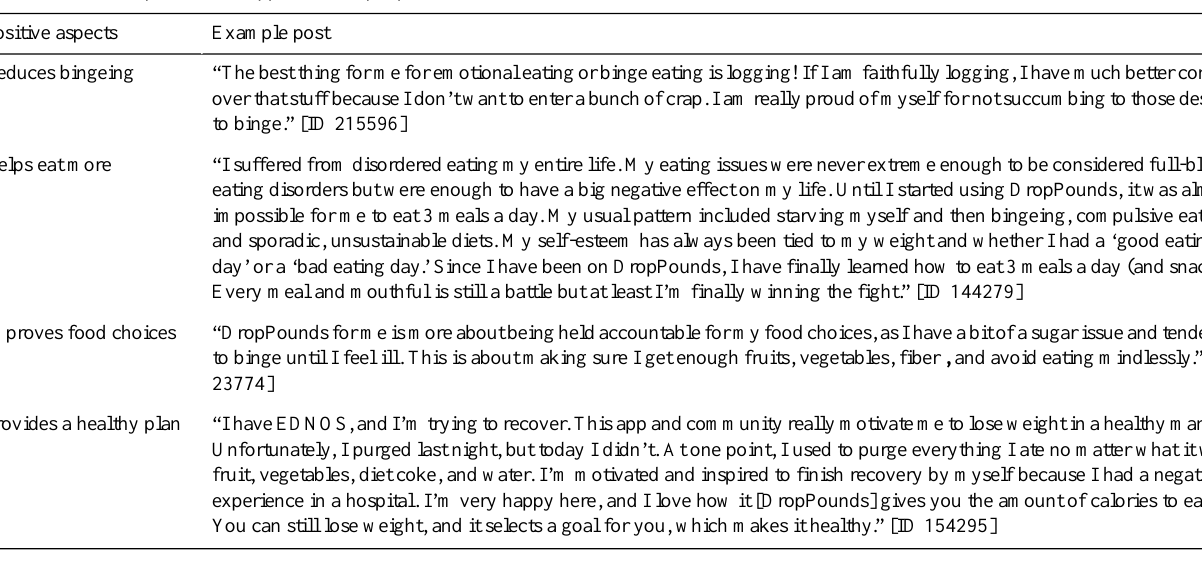
Table 2. Positive aspects of the app and example posts.